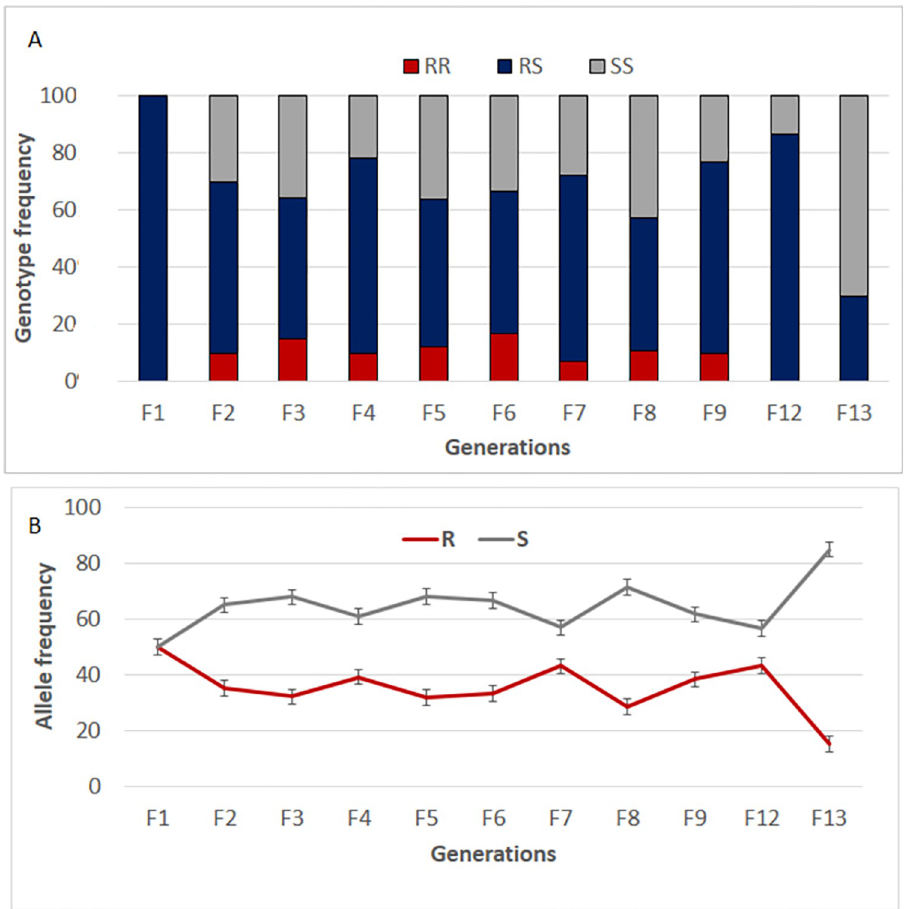
Fig 4. Evaluation of the reversal to susceptibility in the hybrid colony MYG/KIS. Changes in the L1014S genotypes (A) and allele (B) over13 generations in the insecticides free-environment; F represents each generation.